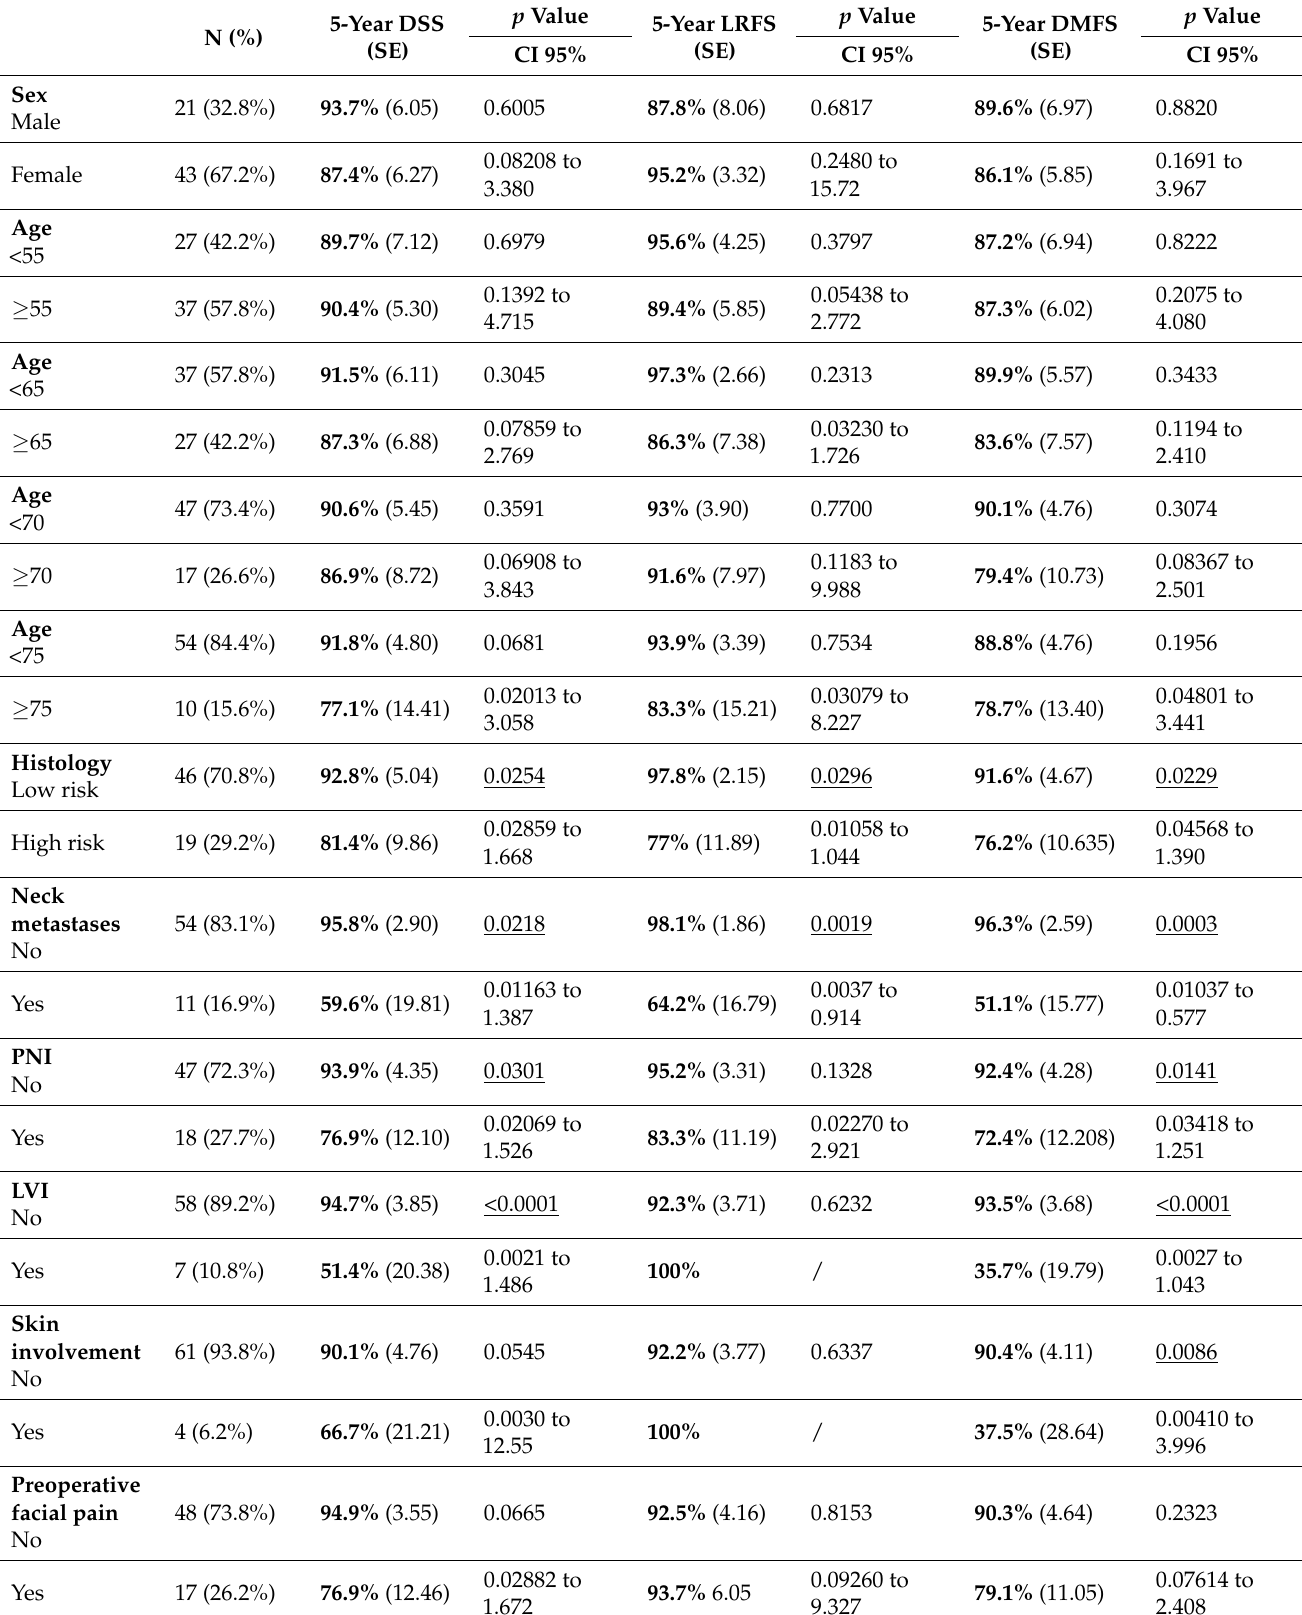
Table 5. Univariate analysis of the survival rates according to risk